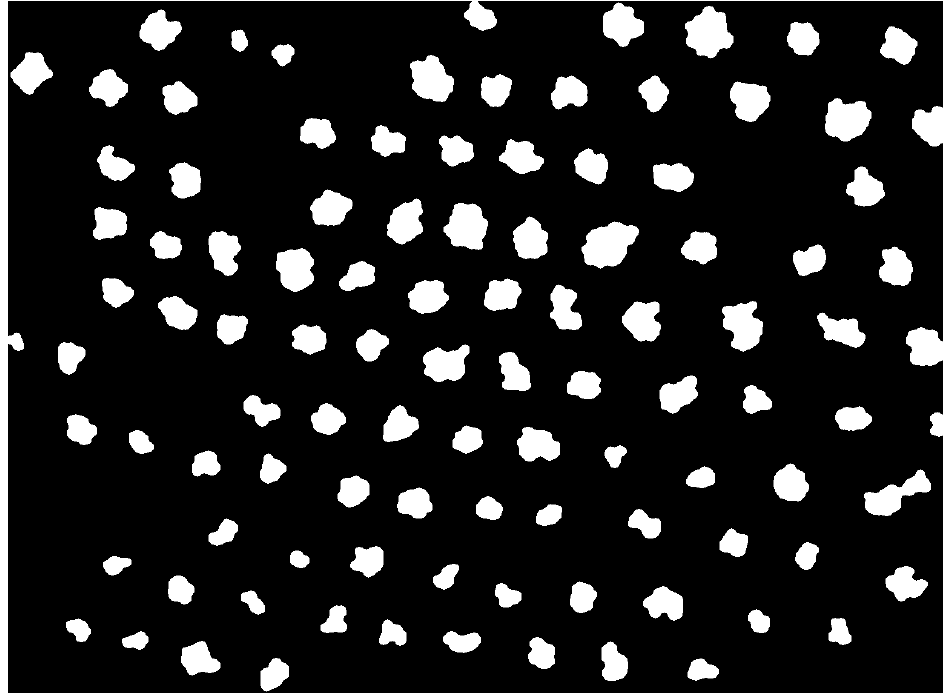
Figure 10. Ground truth associated with capture 0. It is a black and white image in which the white pixels have been manually labeled by a person in order to calculate the quality metrics of the